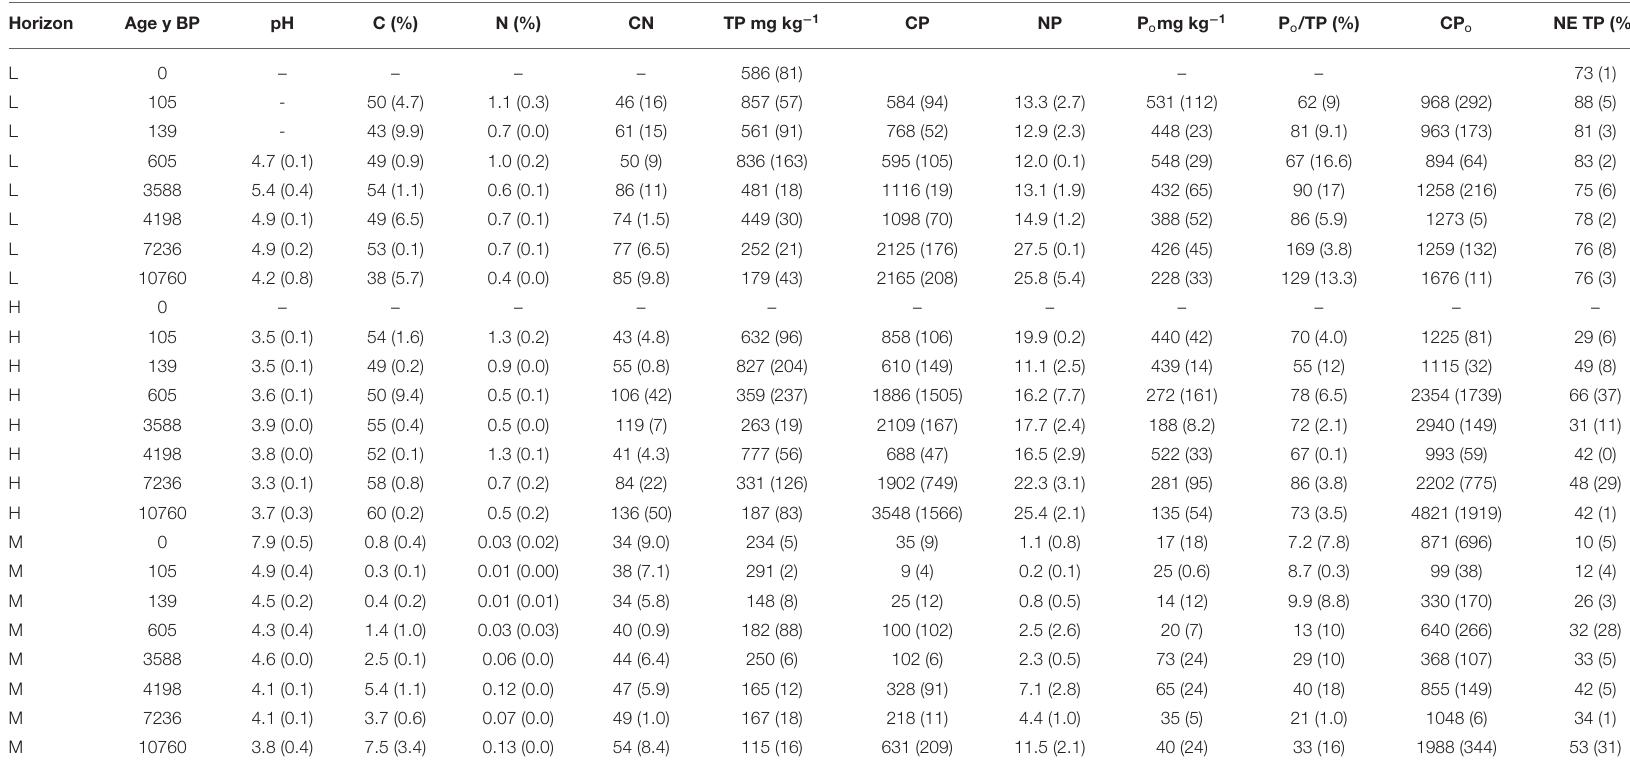
TABLE 3 | Soil pH (in water), total carbon (C), total nitrogen (N), total (TP), and organic P (Po) concentrations within litter (L), humic-enriched organic (H) and mineral (M) horizons, and the recovery of TP in NaOH-EDTA extracts (NE TP).